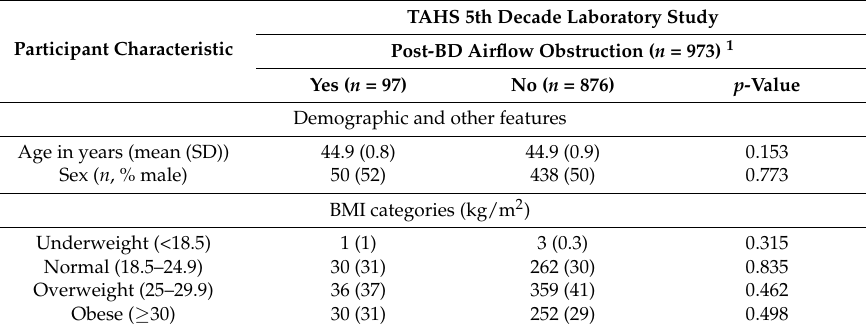
Table 1. Characteristics of the TAHS laboratory study participants, by post-bronchodilator airflow